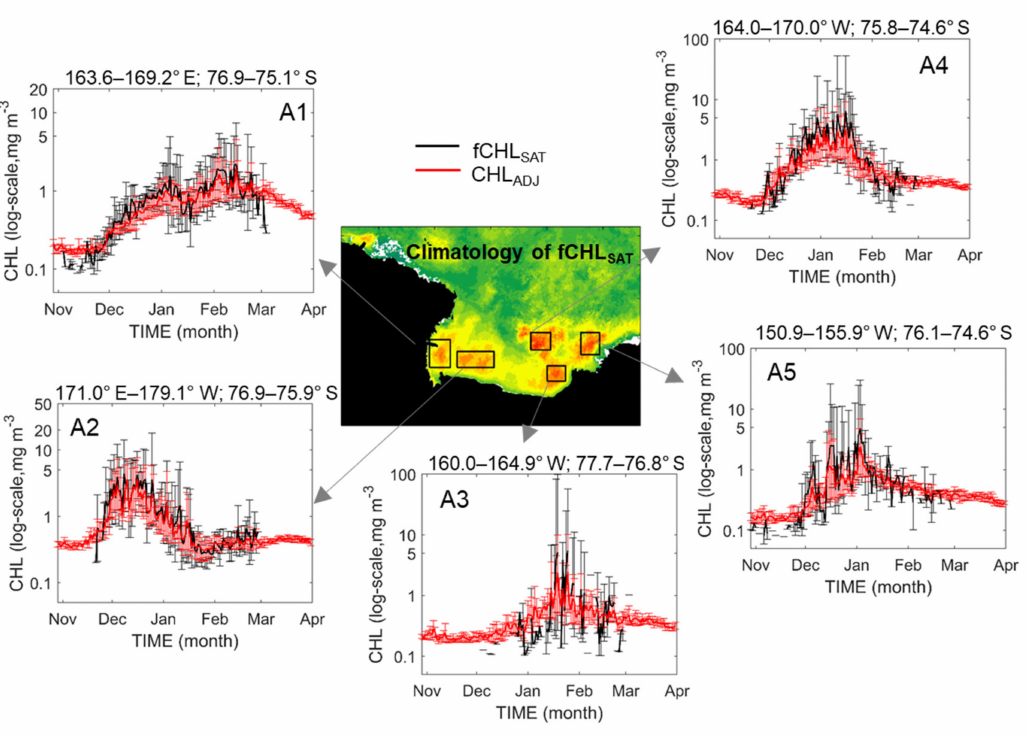
Figure 13. Climatological time–series of the spatially-averaged daily CHL from fCHL SAT (black lines) and CHL ADJ (red lines) for five arbitrary regions; A1 (western Ross Sea), A2 (southern Ross Sea), A3 (o ff cape Colbeck), A4 (eastern Ross continental shelf break) and A5 (eastern Ross Sea). Magnitude of the error bar indicates the annual variation in the